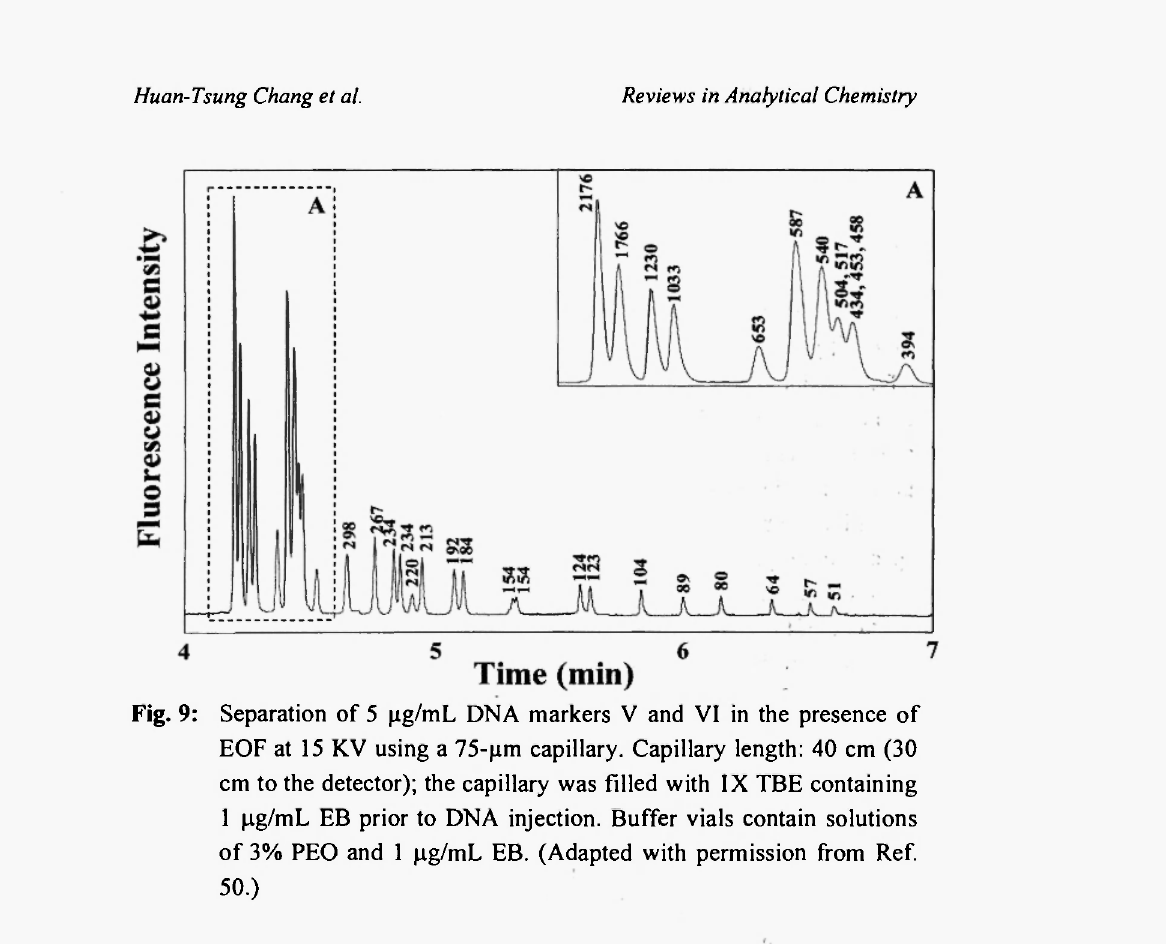
Fig. 9: Separation of 5 μ§/ιηί DNA markers V and VI in the presence of EOF at 15 KV using a 75-μιη capillary. Capillary length: 40 cm (30 cm to the detector); the capillary was filled with IX TBE containing 1 μg/mL EB prior to DNA injection. Buffer vials contain solutions of 3% PEO and 1 μg/mL EB. (Adapted with permission from Ref.